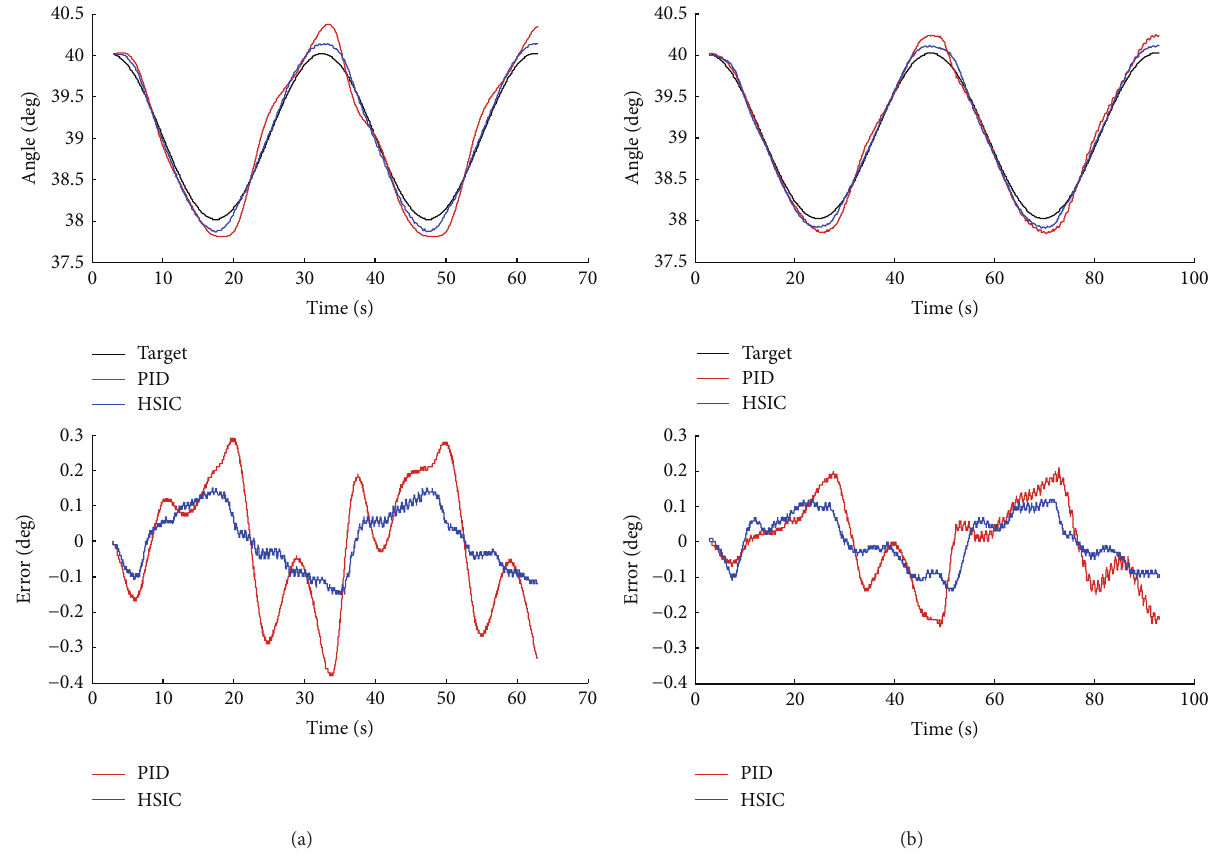
Figure 8: Experimental results of the sinusoidal trajectory. (a) 𝑇 = 30 s and (b) 𝑇 = 45 s.